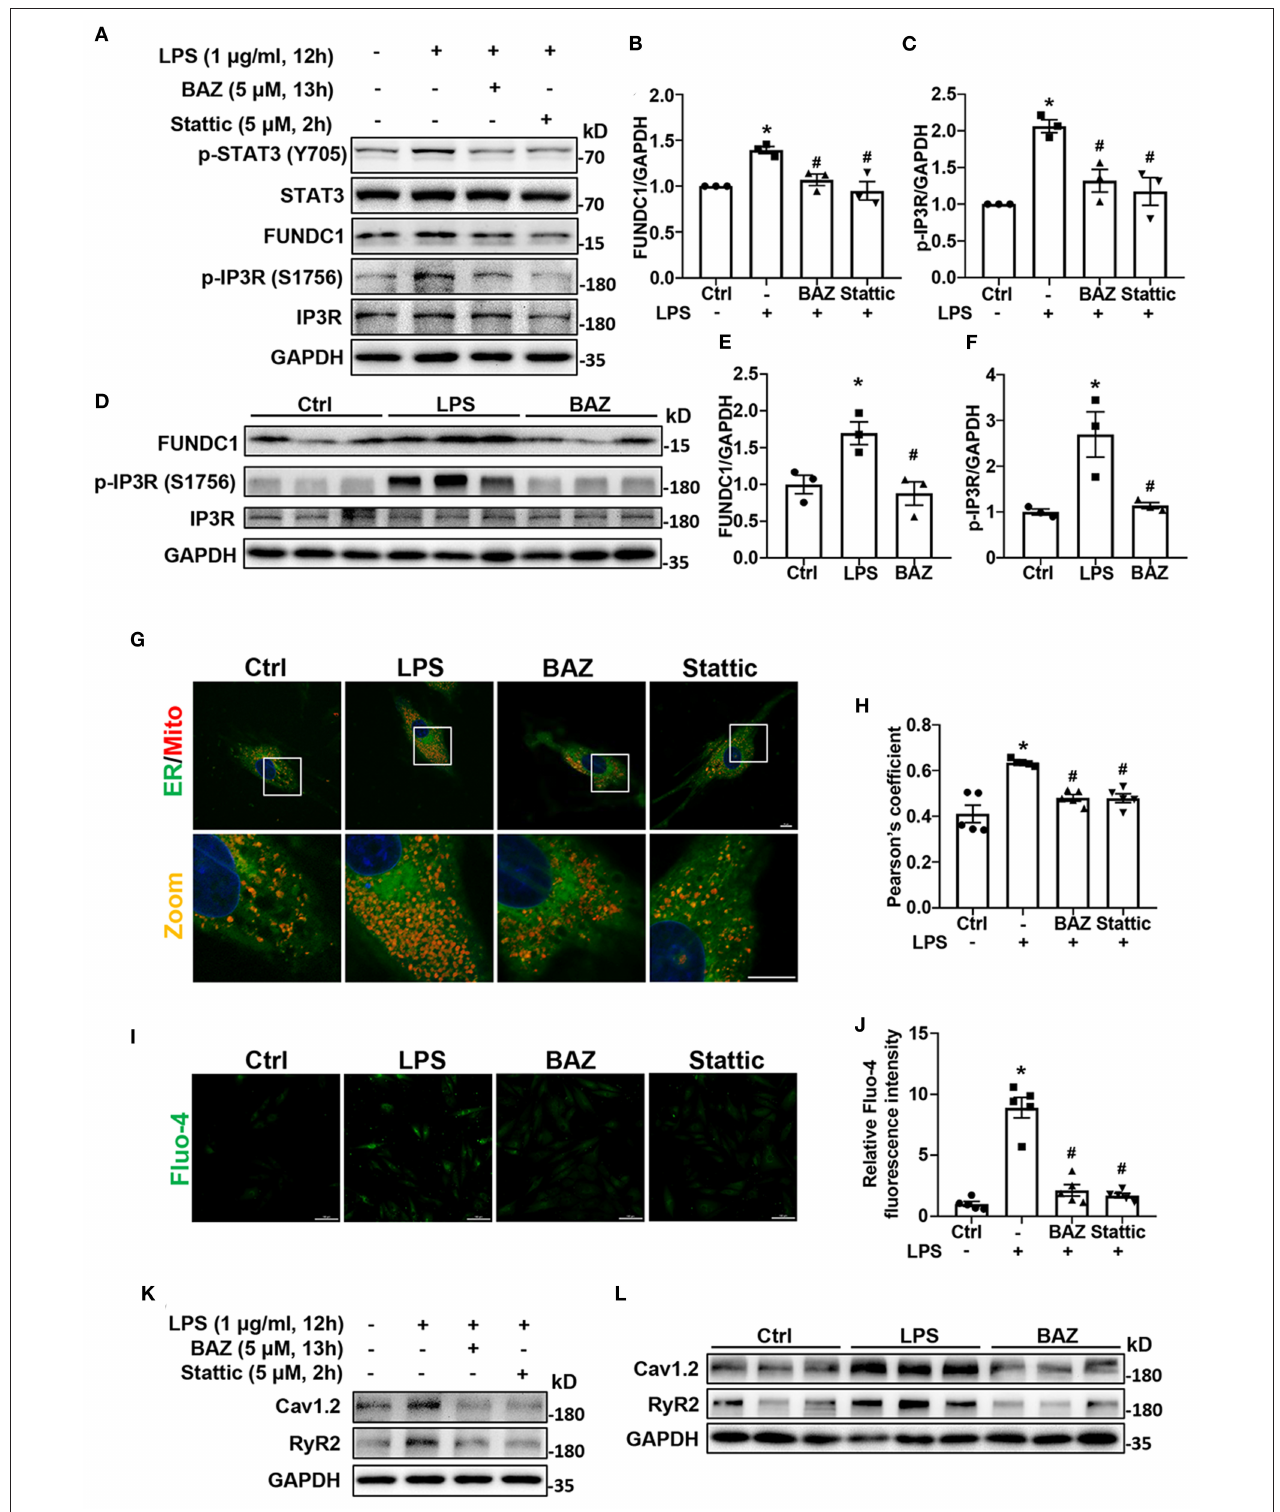
FIGURE 5 | IL-6/STAT3 inhibitor attenuated LPS-induced mitochondria-associated endoplasmic reticulum (ER) membranes (MAMs) formation, intracellular Ca 2 + levels, and expression of calcium signaling-related proteins in H9c2 cells. For LPS stimuli, H9c2 cells were treated with LPS (1 µ g/ml) for 12h. For BAZ group,